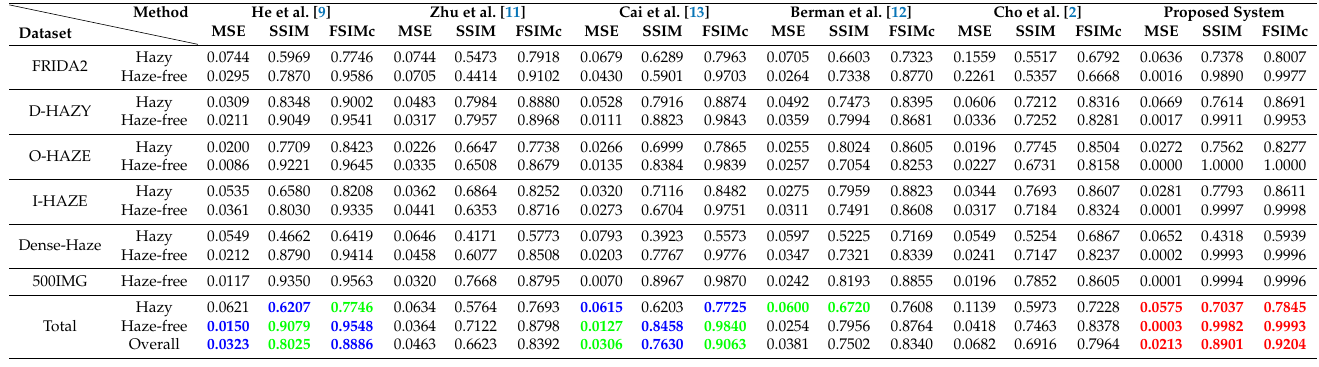
Table 6. Average mean squared error (MSE), structural similarity (SSIM), and feature similarity extended to color images (FSIMc) scores on different datasets. Top three results are boldfaced in red, green, and blue.